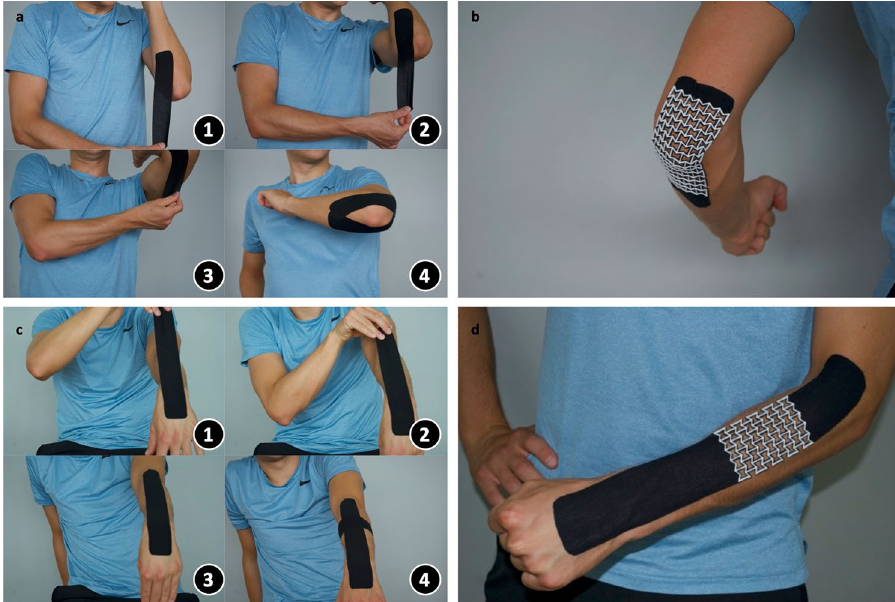
Figure 6. Comparison between the application procedure of the traditional KT and the novel auxetic KT for two cases. ( a ) The traditional KT application procedure for general elbow pain divided into 4 steps. ( b ) The auxetic KT for elbow pain. ( c ) The traditional KT application procedure for forearm muscle tenseness divided into 4 steps. ( d ) The auxetic KT for forearm muscle